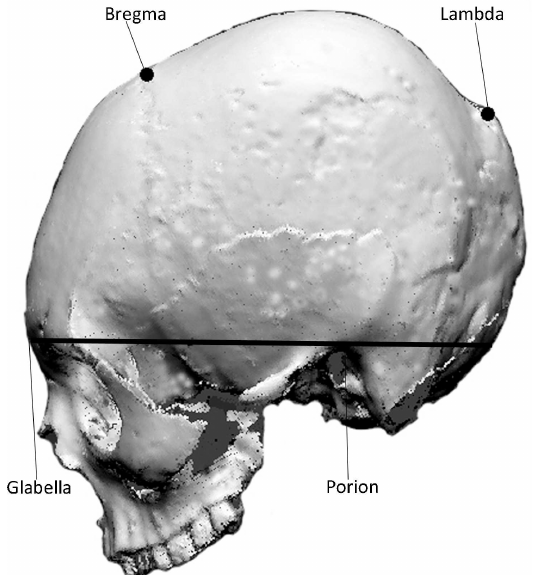
Fig 2. Cranial outline showing bregma and lambda and straight line demarcating cranial